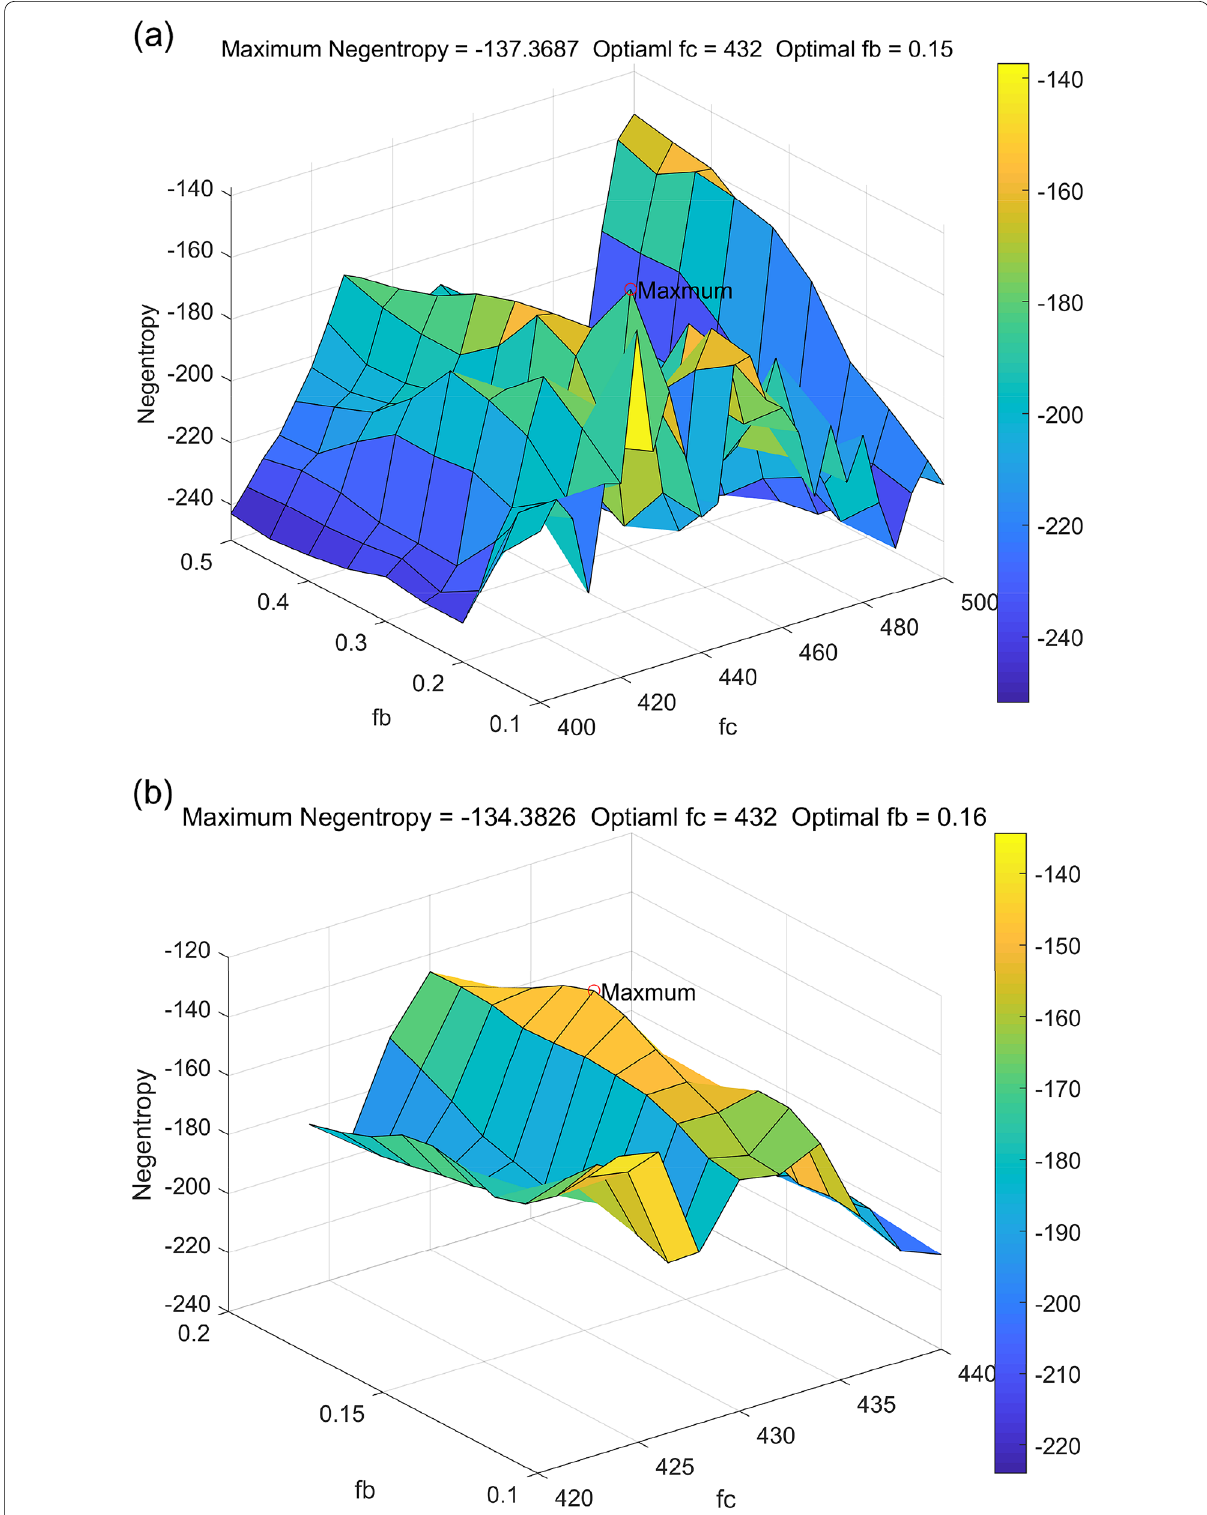
Figure 16 Optimal central frequency and damping ratio obtained by the proposed criterion: ( a ) first and ( b ) second iteration